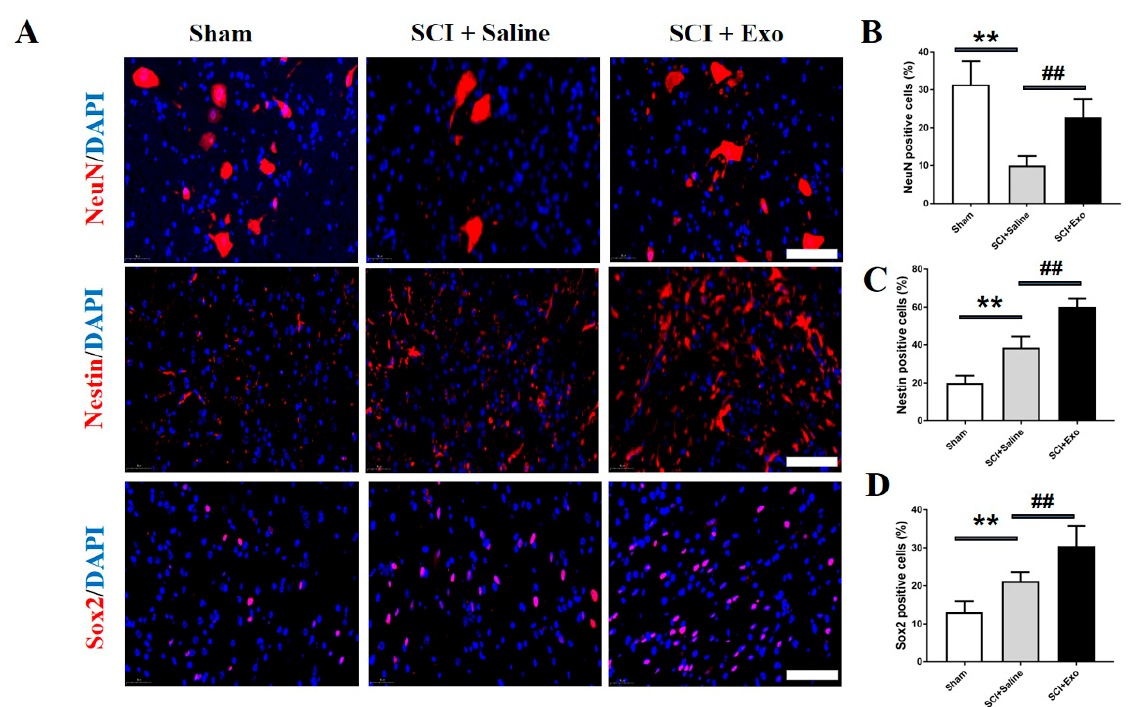
Figure 5. M2 macrophage exosomes promote neurogenesis post-SCI. Representative images of NeuN+ (red), Nestin+ (red), and Sox2+ (red) cells in the anterior horn of the injured SC ( A ). Quantification the NeuN+ cells, Nestin+ cells, and Sox2+ cells in the injured SC ( B – D ). Mean ± SD. ** p < 0.01 SCI + saline group versus sham group, ## p < 0.01 SCI + Exo versus saline group. N = 5 per group. Bar = 50 μ m.